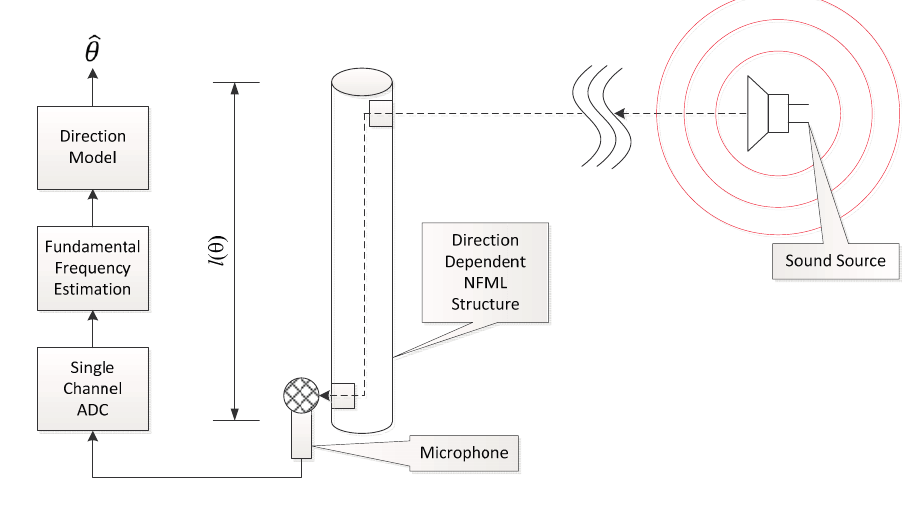
Figure 2. System architecture of proposed NFML